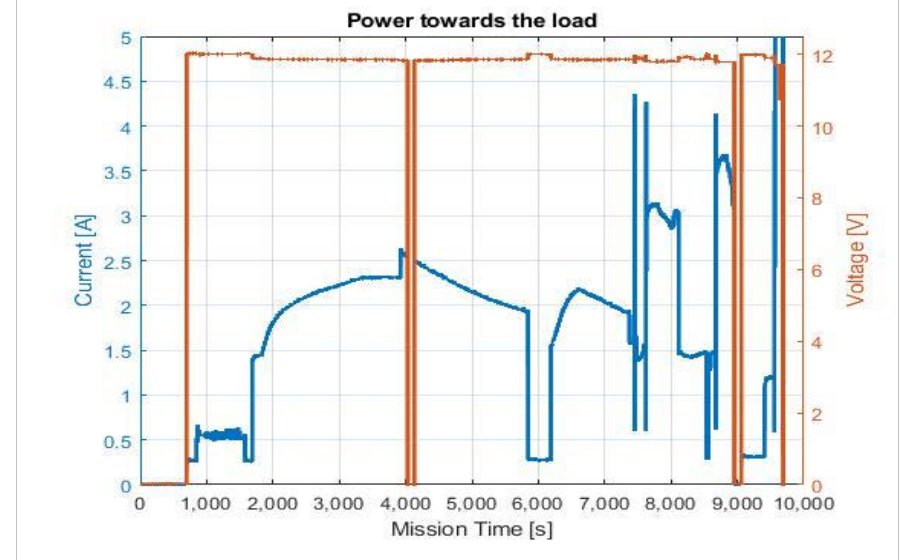
Figure 10. Power consumption during the Environmental tests.